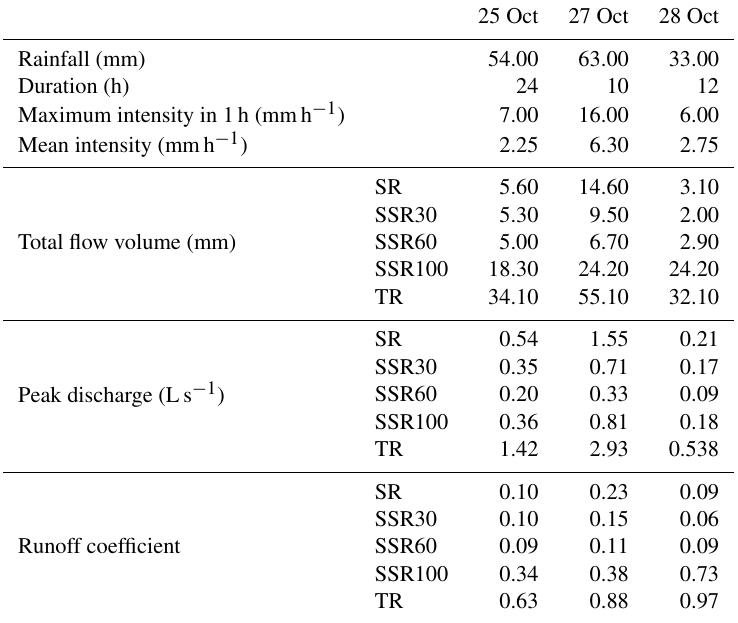
Table 1. Principal hydrological characteristics of the flood event in